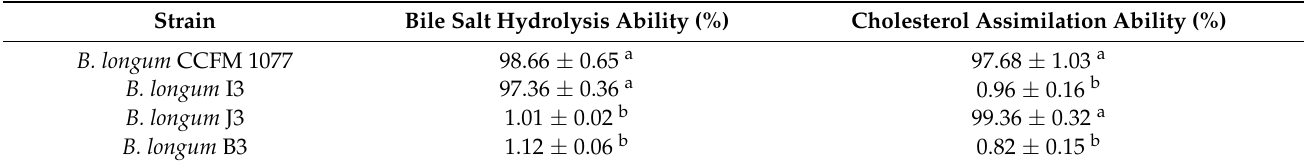
Table 2. Bile salt hydrolysis ability and cholesterol assimilation ability of B. longum strains.